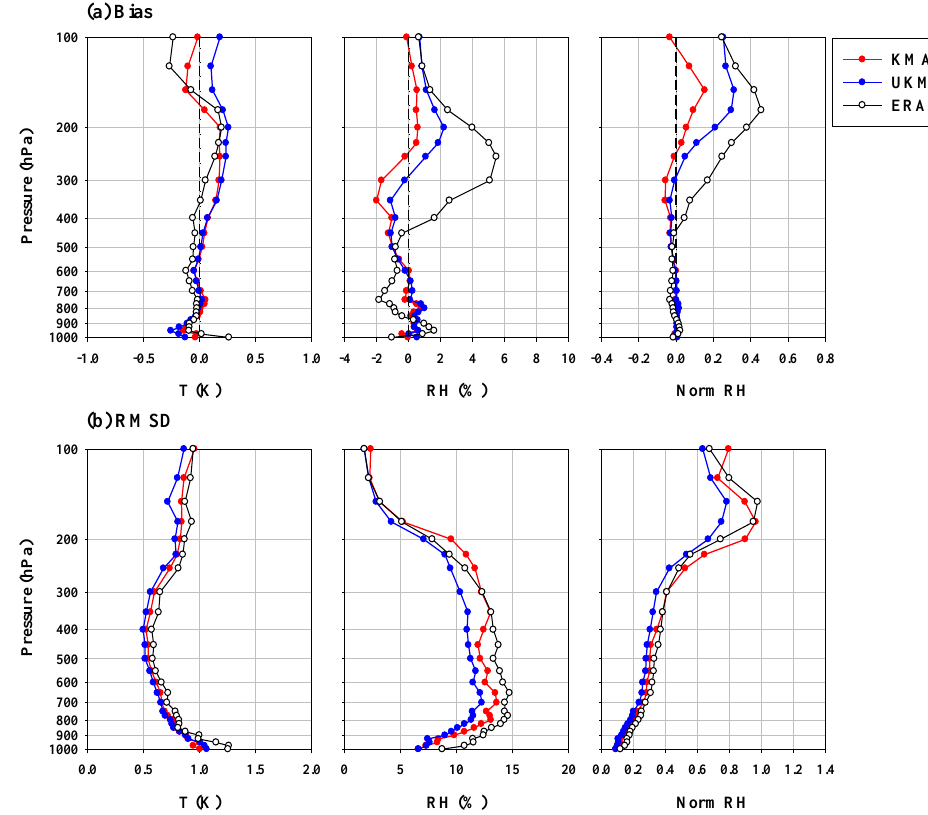
Figure 2. Vertical distributions of the mean biases ( a ) of the temperature, relative humidity, and normalized relative humidity for UM-KMA, UM-UKMO, and ERA-I. Their related root mean square differences (RMSDs) ( b ) are shown in the three panels.